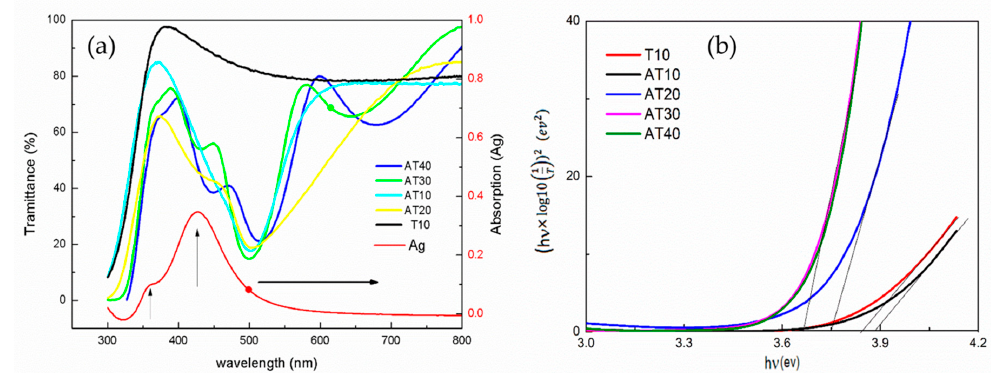
Figure 3. ( a ) The transmittance and absorption spectra of the samples. ( b ) The optical energy gap calculated by the Tauc equation.